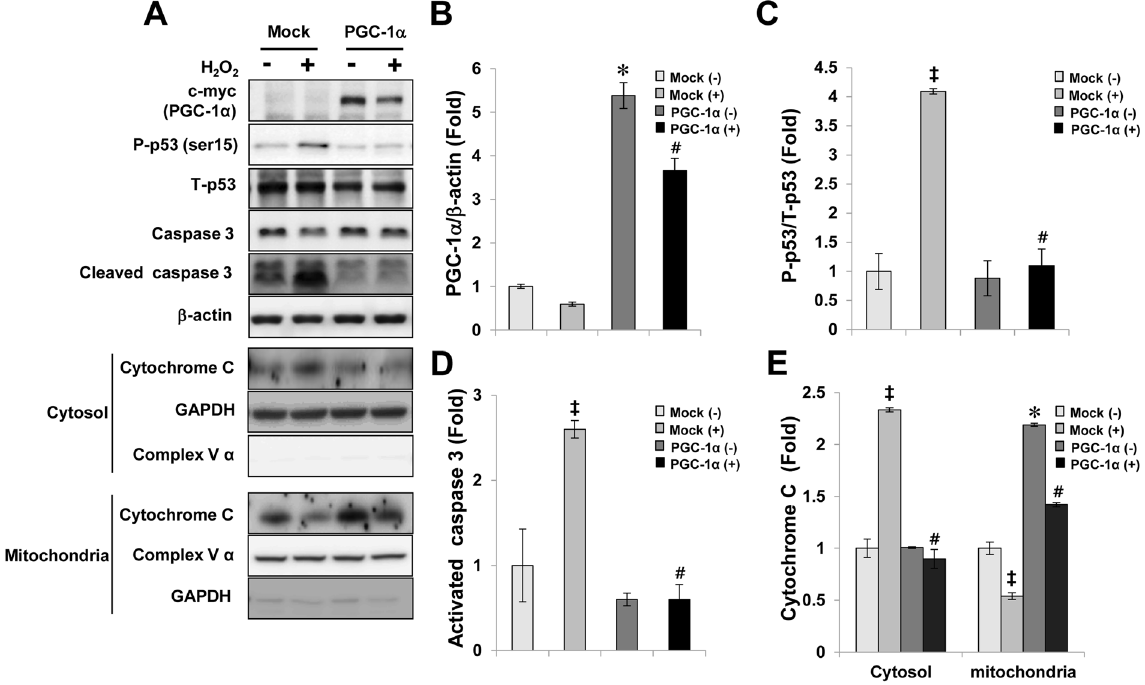
Figure 4. Anti-apoptotic effect of PGC-1 α . Stable cells were treated with 0.5 mM H 2 O 2 for 6 h. ( A ) The expression bands of apoptotic proteins in Mock and PGC-1 α -stable cells were compared via western blotting. Each bar graph represents the expression of PGC-1 α ( B ), ratio of phosphorylated p53 at Ser 15 to total p53 ( C ), the level of activated caspase 3 (ratio of cleaved caspase 3 to caspase 3 ( D ), and the level of cytochrome C release from mitochondria to cytosol ( E ). β -actin levels were analyzed as internal controls. GAPDH and complex V α were used as internal controls in cytosol and in mitochondria fraction, respectively. Full-length blots of each tested protein are reported in Supplementary Figure S4. Error bars denote the mean ± S.D. of triplicate samples. * p < 0.05 H 2 O 2 -untreated Mock vs. PGC-1 α ; # p < 0.05; H 2 O 2 -treated Mock vs. PGC-1 α ; ‡ p < 0.05; H 2 O 2 -treated Mock vs.